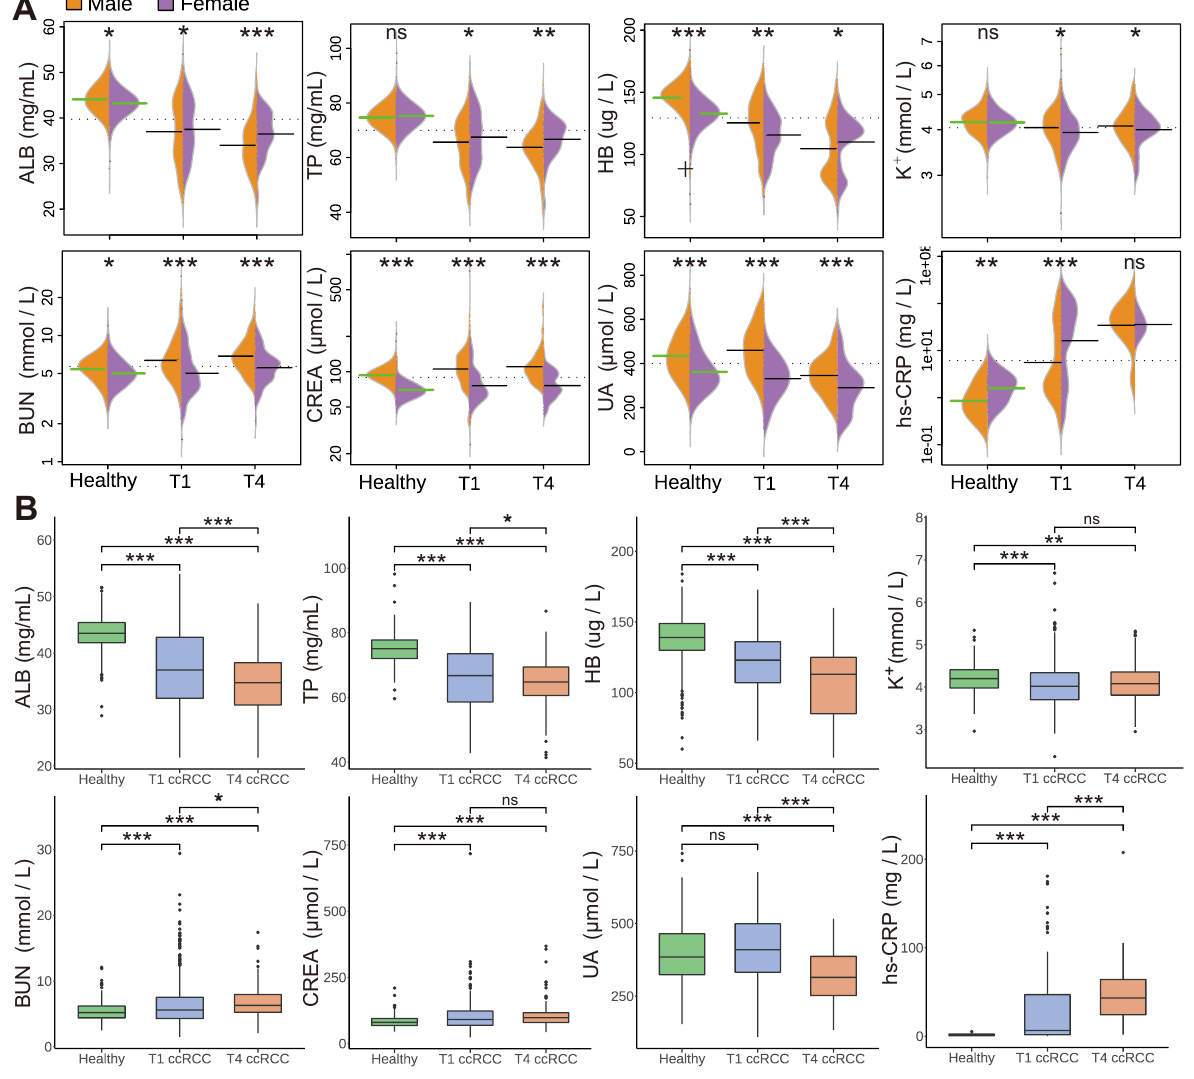
Figure 3. The distribution of the significant difference between indicators. ( A ) The significant differ- ence between male and female indicators in the healthy populations and cancer patients. ( B ) The statistical significance analysis of ccRCC and healthy people. The statistical significance analysis of indicators with protein, renal function, inflammation, etc. (*** means “ p < 0.001 statistically signif- icant”; ** means “ p < 0.01 is statistically significant”; * means “ p < 0.05 is statistically significant”; insignificance is denoted by